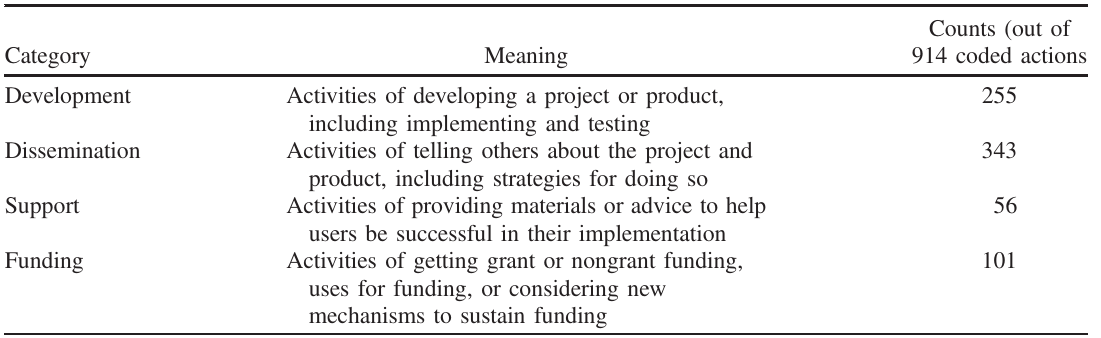
TABLE IV. Categories used in coding interviews from the three well-propagated strategies. Each main category contains subcodes.